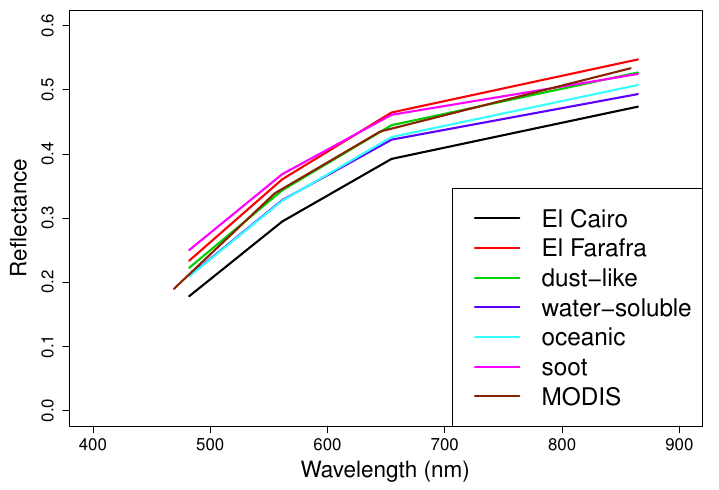
Figure 5. The OLI surface reflectance retrieved by applying of the OLI Atmospherically-Corrected Reflectance Imagery (OLI@CRI) algorithm considering the aerosol microphysical properties as the inverse products of Cairo and El Farafra AERONET stations and as the four basic component included in the 6SVmodel (dust-like, water-soluble, oceanic and soot